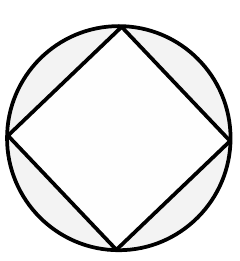
Figure 5. Squaring the circle: An optical illusion of discomfort.